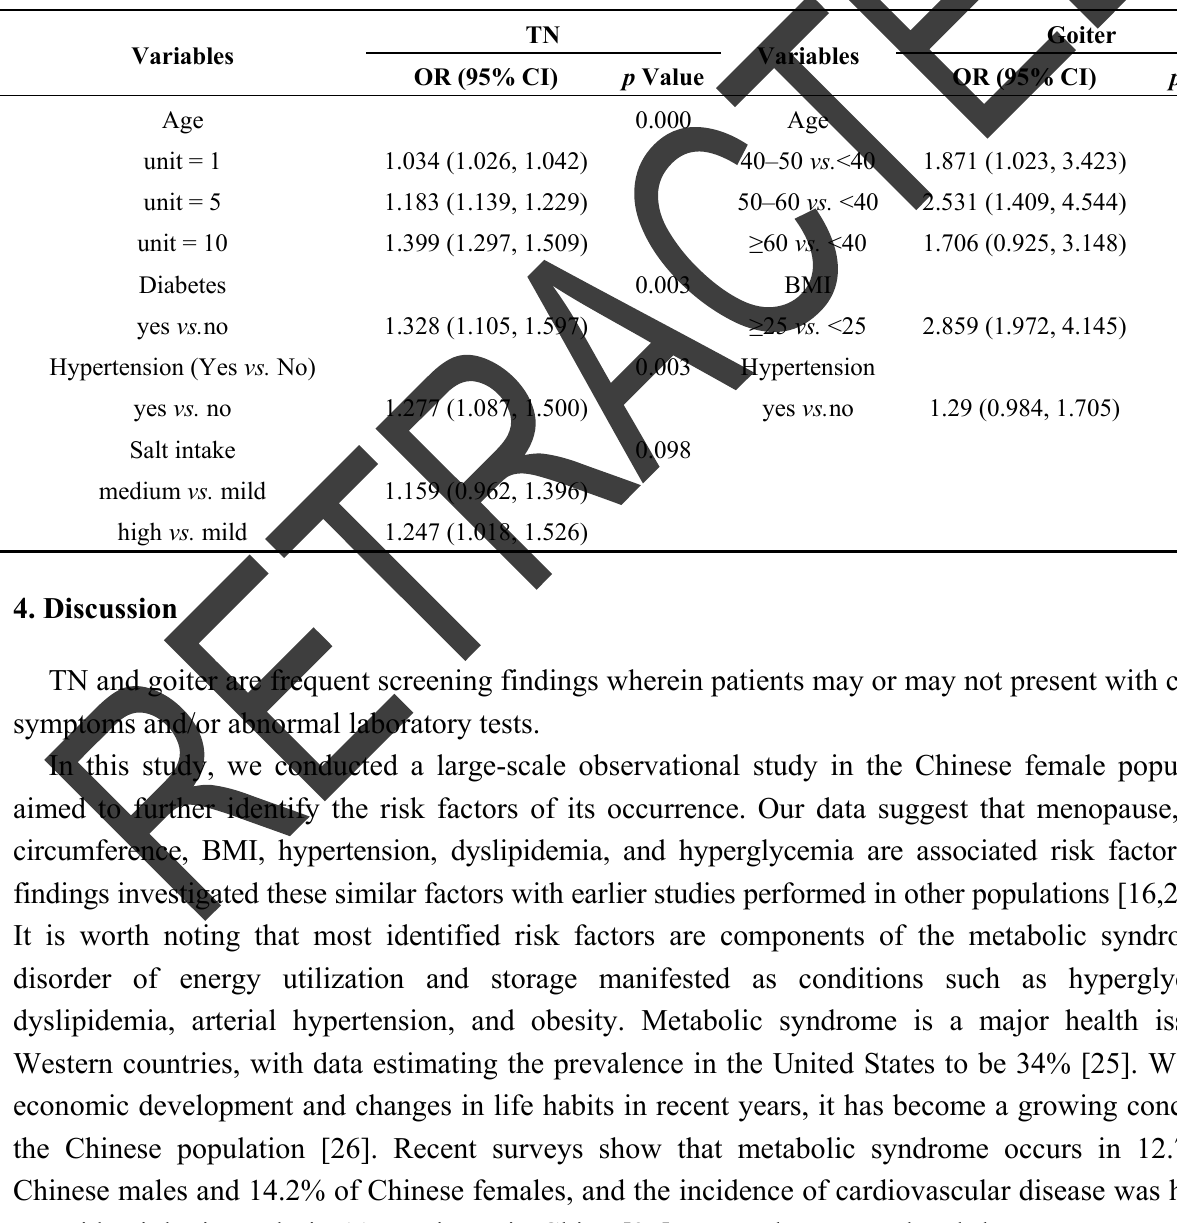
Table 5. Analysis of associations for TN or